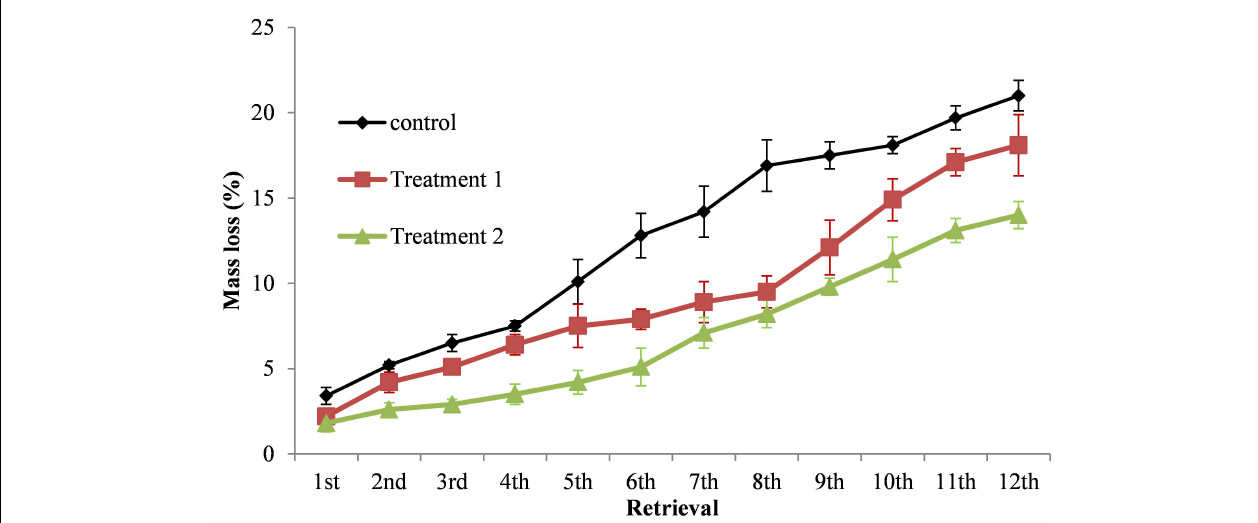
FIGURE 3 | Comparative leaf litter mass loss of different extreme drought treatments at different retrieval times. Bar heights are means ± 1 SE for the error bars. Treatment 1, decreased precipitation amount by 2/3 in the growth season (May 1–August 31); Treatment 2, increased precipitation interval in the early stage of growth season (May 1–June 30); control, natural